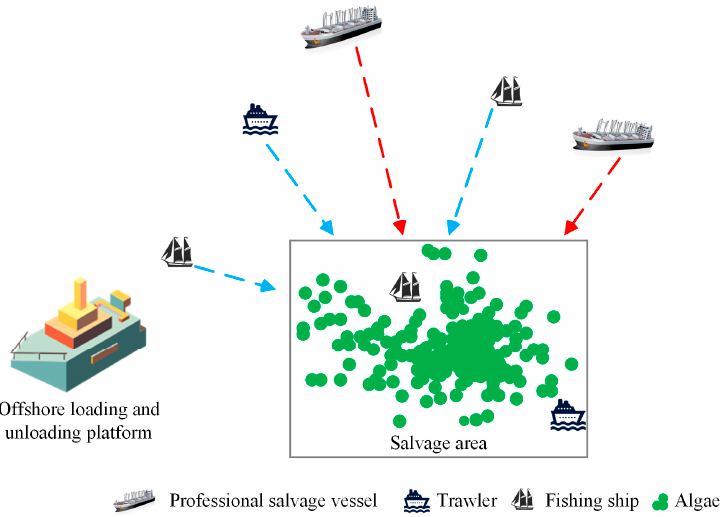
Figure 1. Schematic diagram of emergency disposal for green tide disaster. Decision-makers should pay attention to the drifting characteristics of the green tide when making emergency disposal plans. The positions of the green tide constantly change due to drift motion, which will lead to the distance between the salvage vessel and the salvage area being a time-varying parameter. Therefore, the drift characteristics of green tide will affect the decision-making of emergency disposal